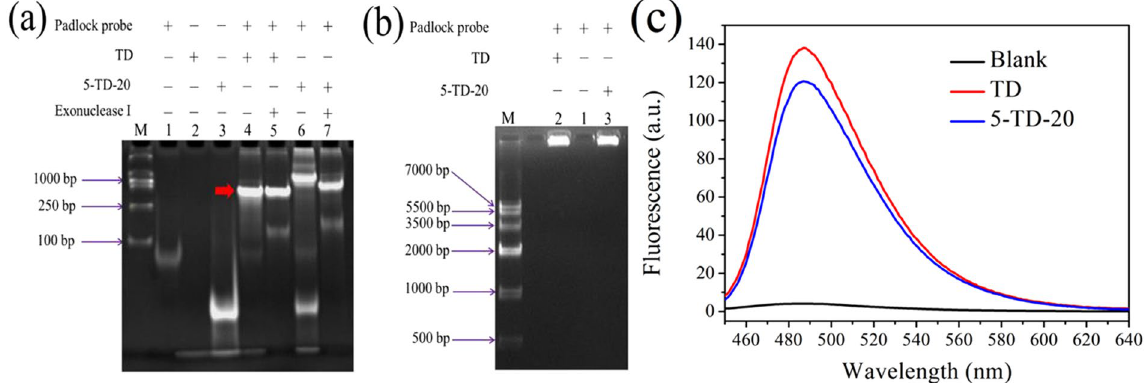
Figure 2. ( a ) Non-denaturing PAGE assay of circularization products produced under different conditions. Lane M is the DNA ladder marker. The experimental conditions for lanes 1–7 are shown in the top of the figure.